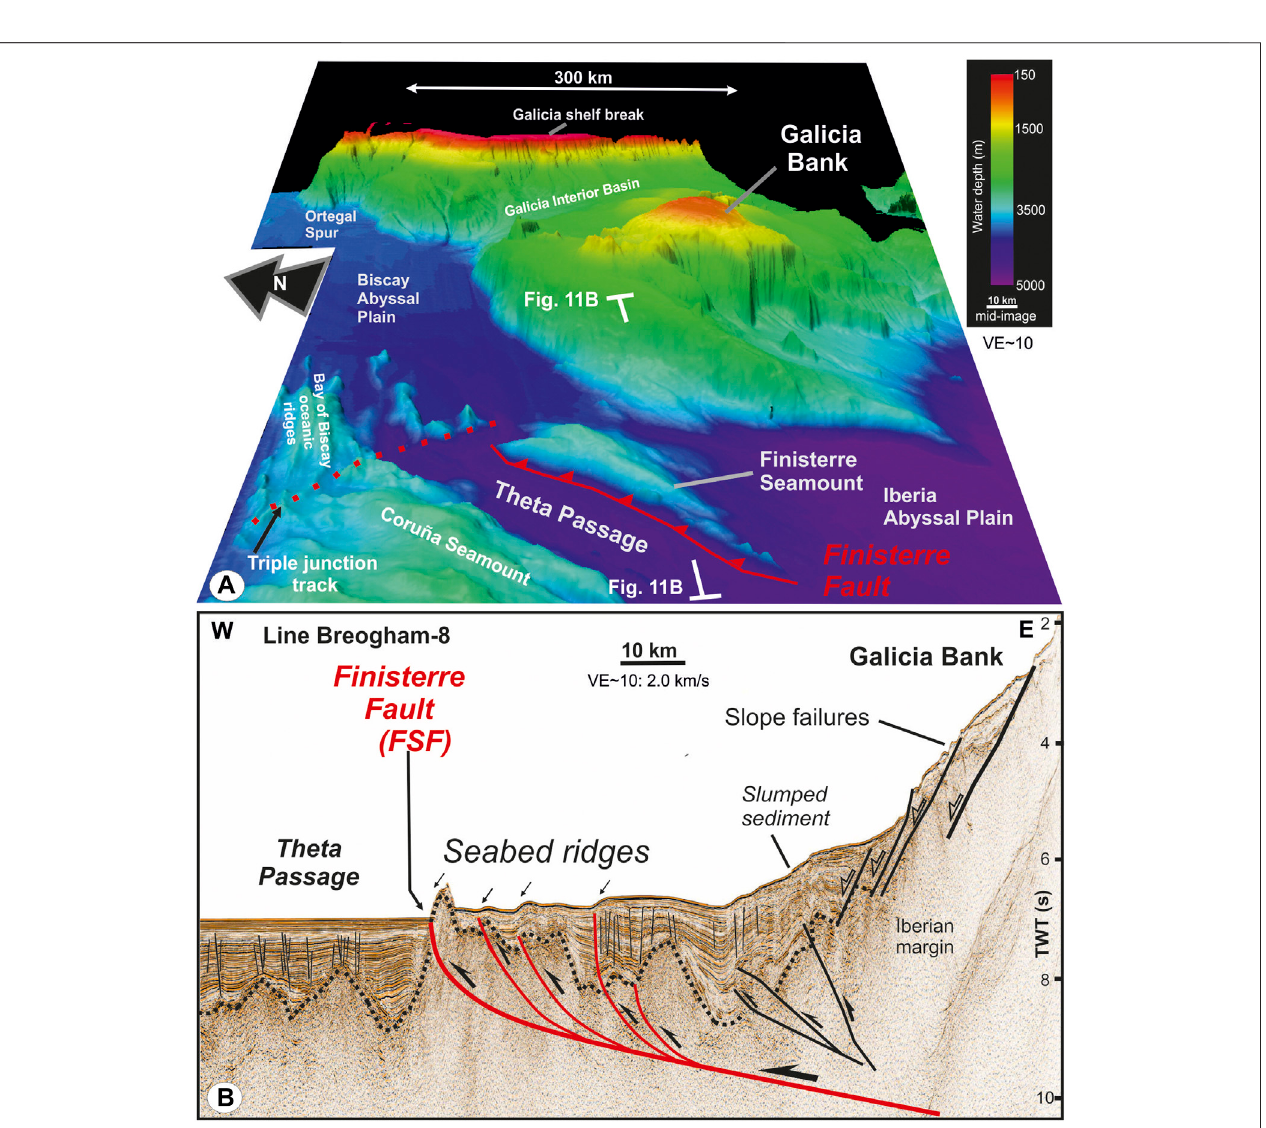
FIGURE 11 | (A) Multibeam bathymetry of the NW Iberian Margin showing the location of the Finisterre Thrust Fault interpreted as the former boundary between the NorthAtlanticplateandIberia. (B) MultichannelseismiclineBREOGHAM-08showingtheFinisterrethrustsystemdeformingtheuppermostsea fl oor.Seelocationin Figure1 .